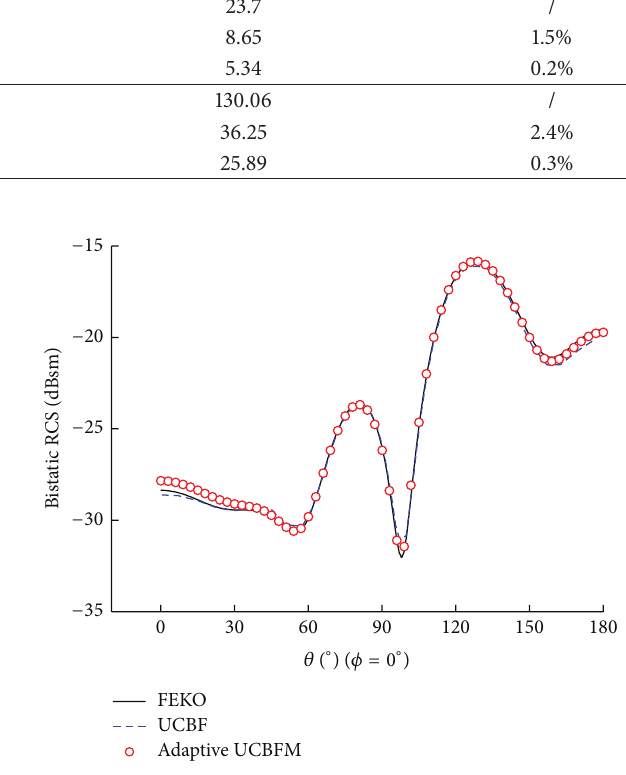
Figure 4: Broadband monostatic RCS of almond. Figure 5: Bistatic RCS of PEC almond at 2.1